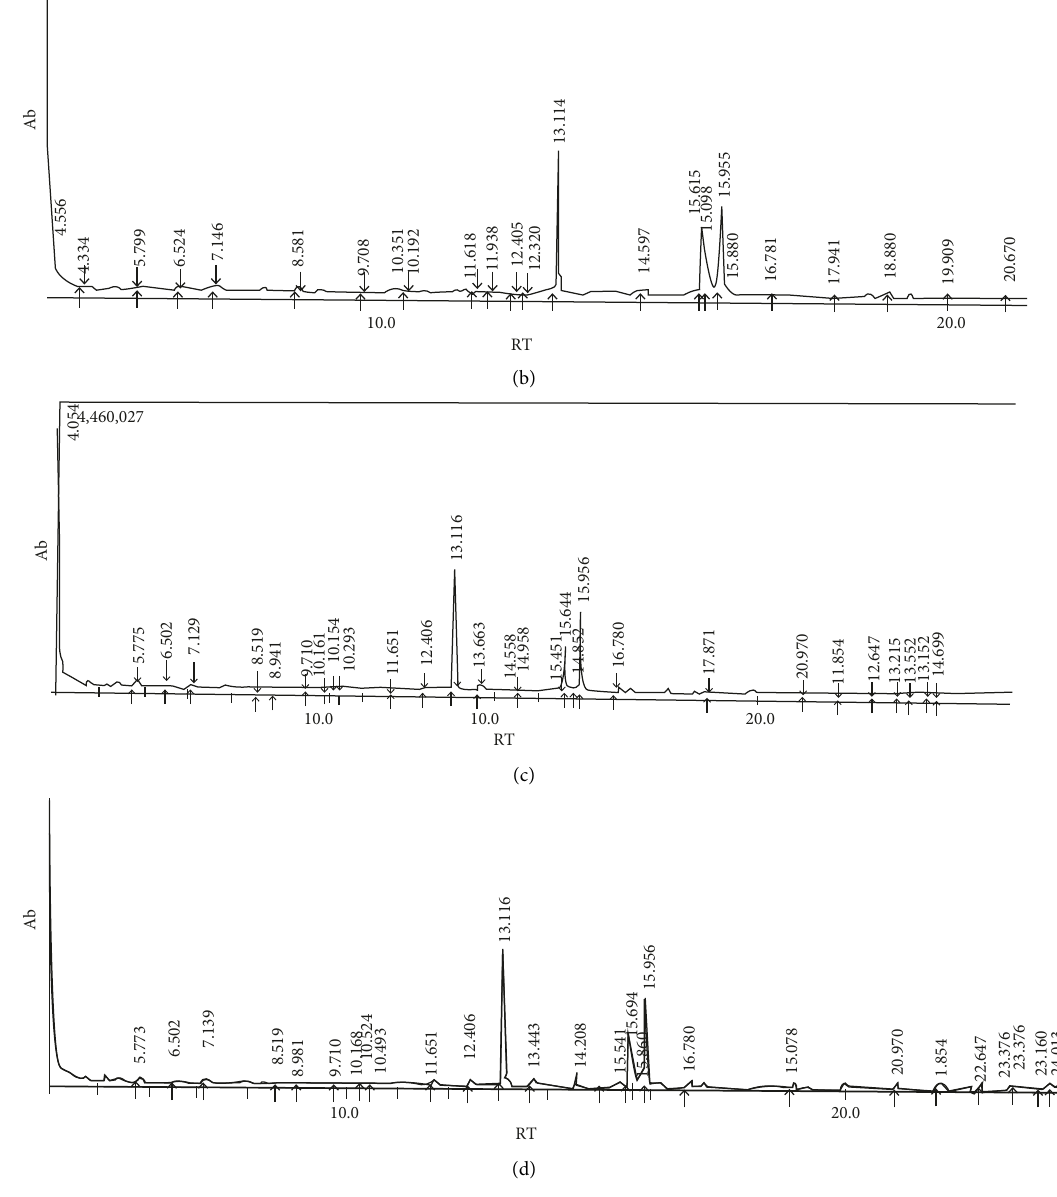
Figure 2: (a) Ether 1: major composition-hexadecanoic acid, methyl ester (13.116), and methyl stearate (15.937). (b) Ether 2: major composition-hexadecanoic acid, methyl ester (13.114), and methyl stearate (15.955). (c) Ether 3: major composition-hexadecanoic acid, methyl ester (13.116), and methyl stearate (15.956). (d) Ether 4 and 5: hexadecanoic acid, methyl ester (13.116), and methyl stearate